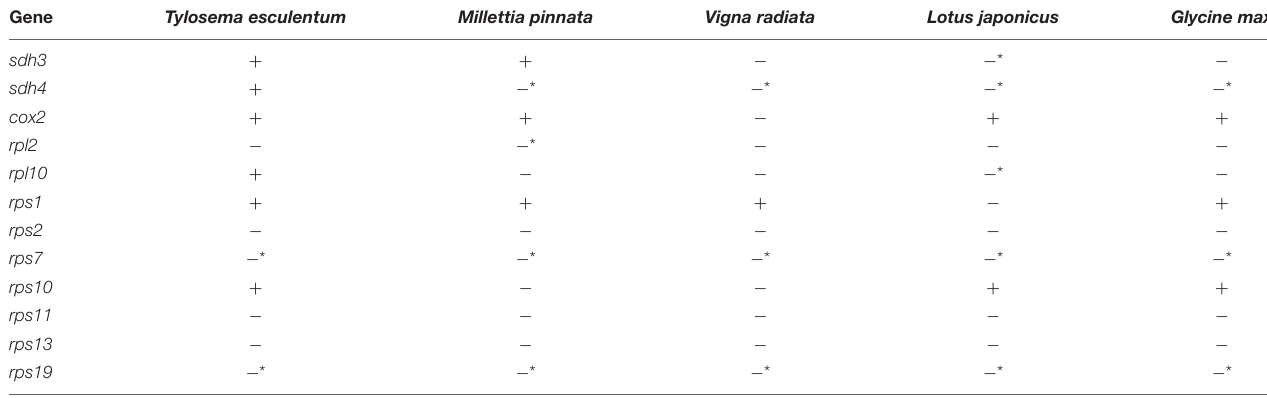
TABLE 4 | Comparison of some protein coding genes known to be variable between Fabaceae